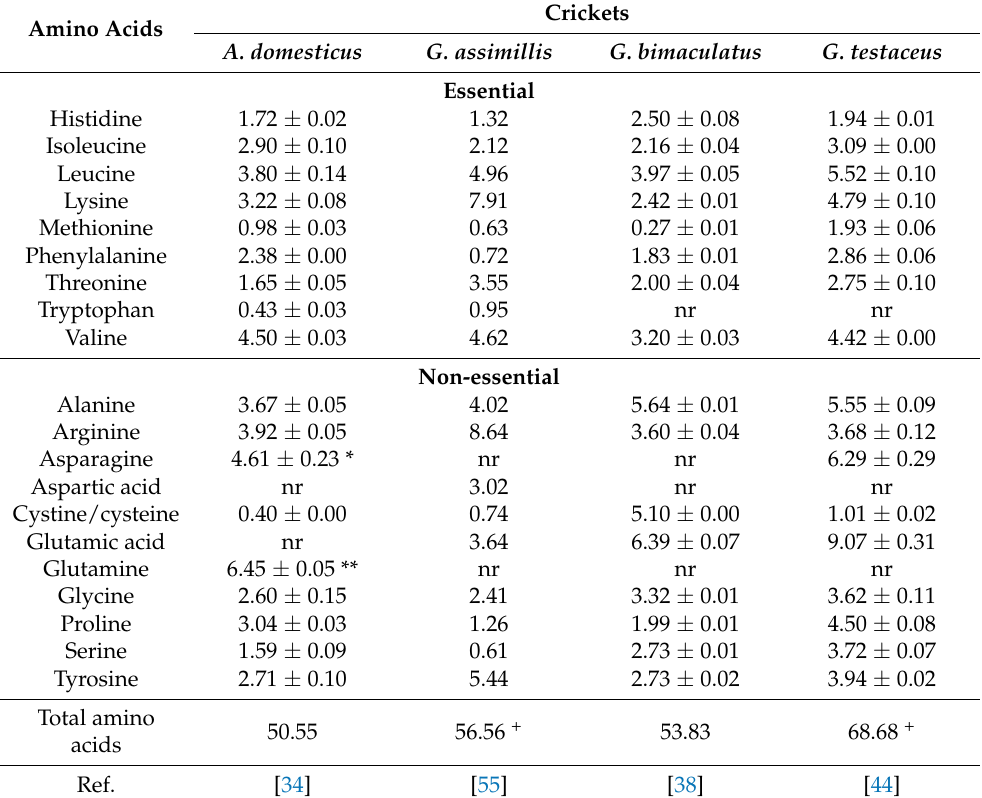
Table 3. Amino acid composition (g/100 g dry matter) of four non-processed edible crickets. Amino